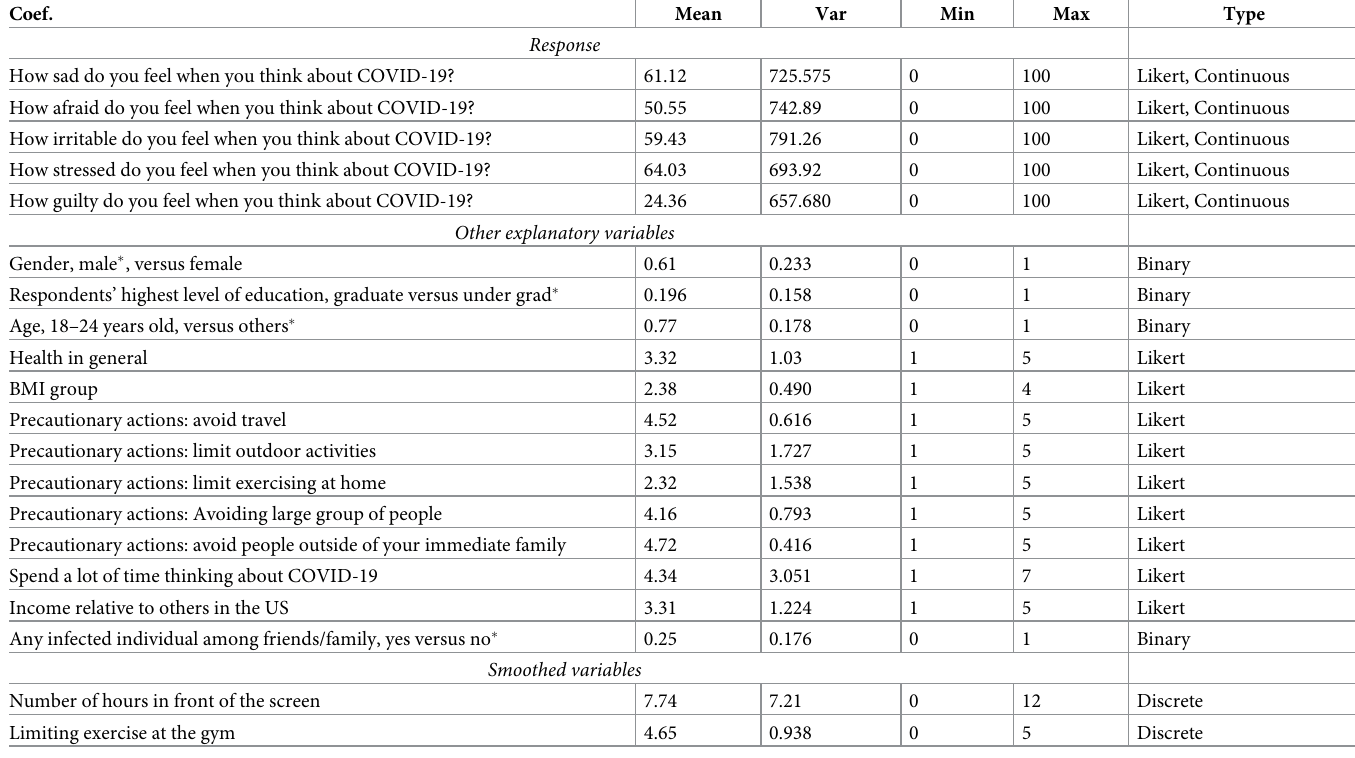
Table 1. Descriptive statistics of important predictors considered in the analysis.